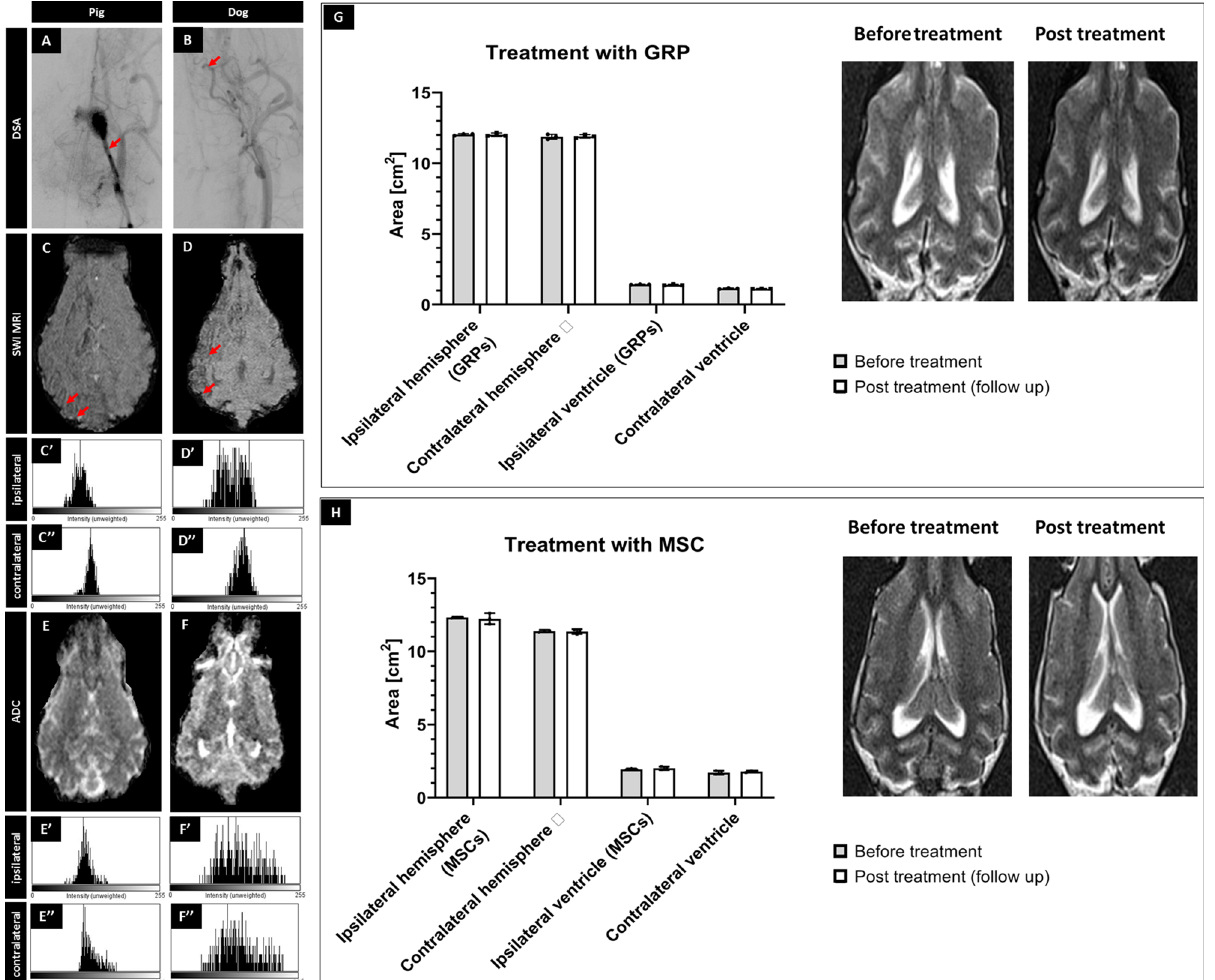
Figure 2. Safety of the procedures. X-ray evaluation of catheter placement ( A , B ; arrows indicate placement of the tip of microcatheter). SWI ( C , D ) with histograms from ipsilateral ( C ′ , D ′ ) and contralateral ( C ″ , D ″ ) hemisphere showing the accumulation of hypointense pixels in the ipsilateral hemisphere. ADC scans ( E , F ) after pig’s and canine’s MSC transplantation with histograms from ipsilateral ( E ′ , F ′ ) and contralateral ( E ″ , F ″ ) hemisphere showing any changes in diffusion after cell transplantation. Evaluation of size of hemispheres and ventricles visible on the MRI before versus post-transplantation of GRPs ( G ) and MSCs ( H ) showing no differences in size before and after